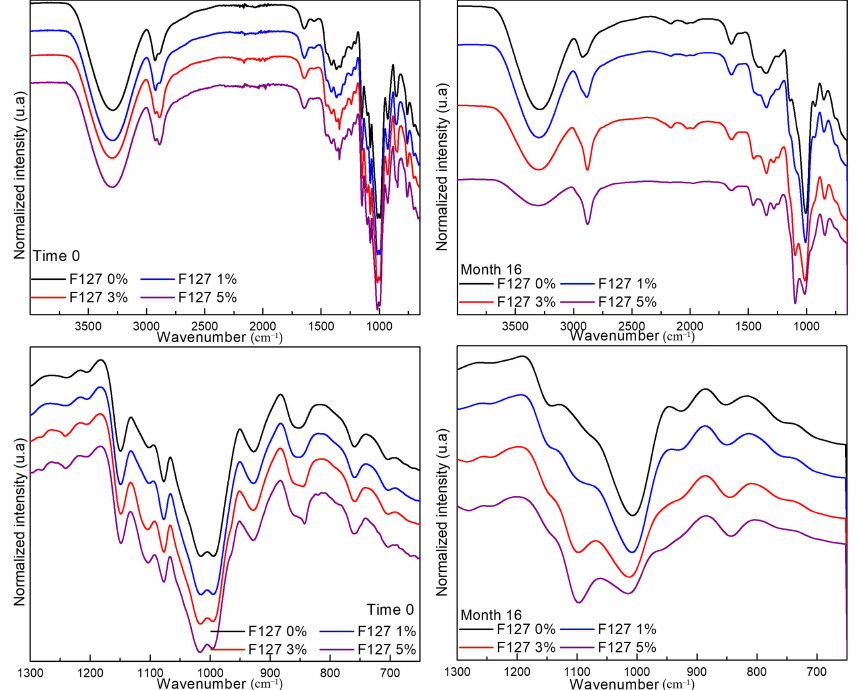
Figure 3. FTIR spectra of biodegradable films of corn starch-chitosan with pluronic F127 at ratios of 0%, 1%, 3%, and 5% stored for 0 and 16 months.